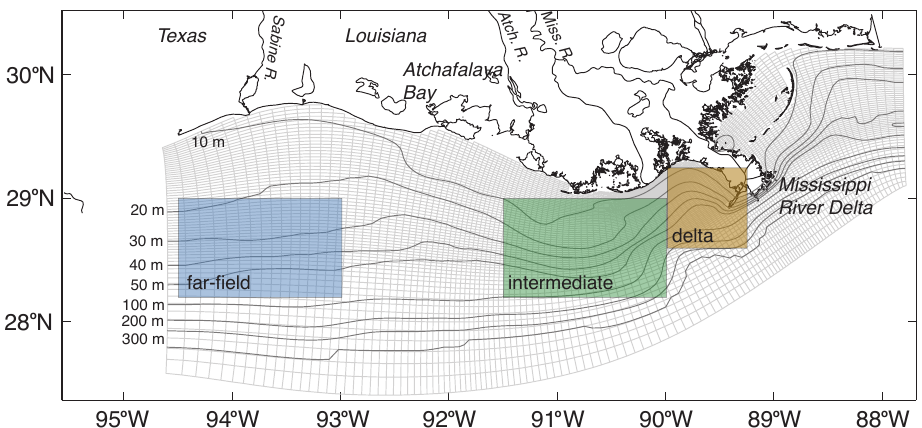
Fig. 1. Model domain and bathymetry. The colored boxes indicate areas used for averaging throughout the manuscript and are referred to as delta (brown), intermediate (green) and far-field (blue) region in the